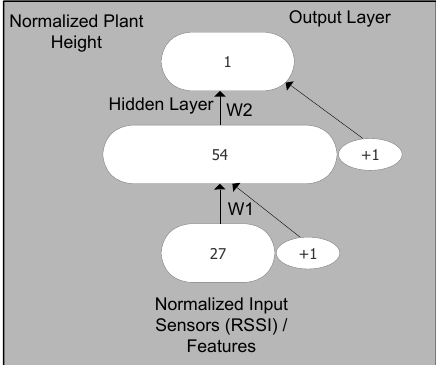
Figure 9. MLP architecture illustrating input, hidden, and output